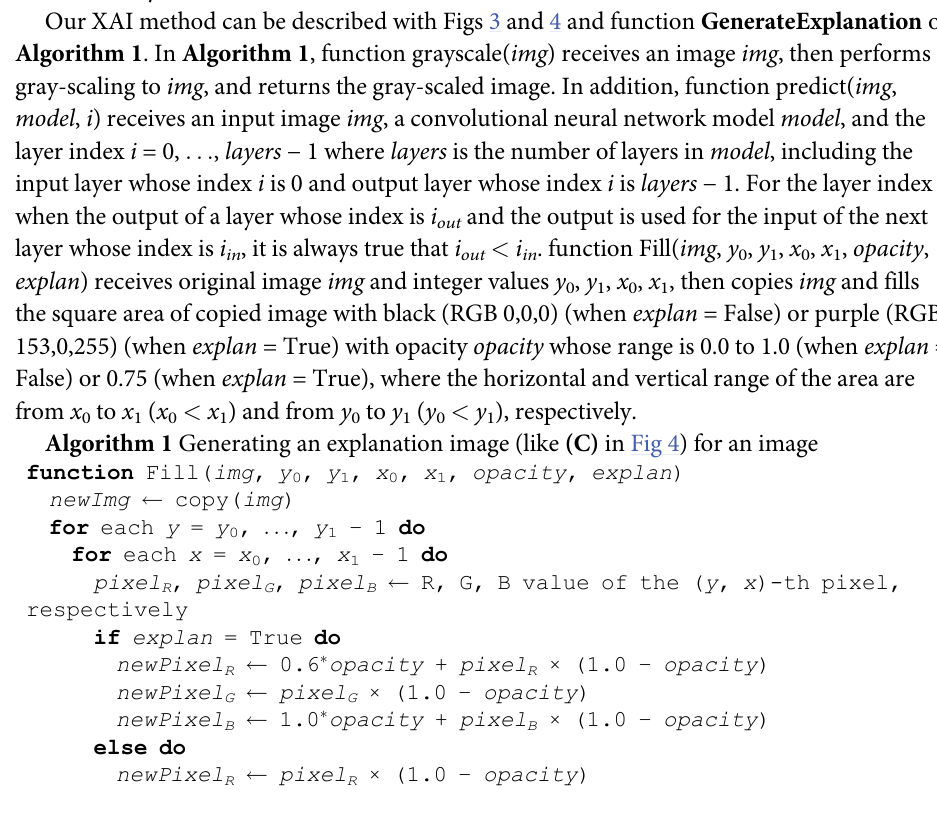
, V ), the more clear the purple color for the O n , m